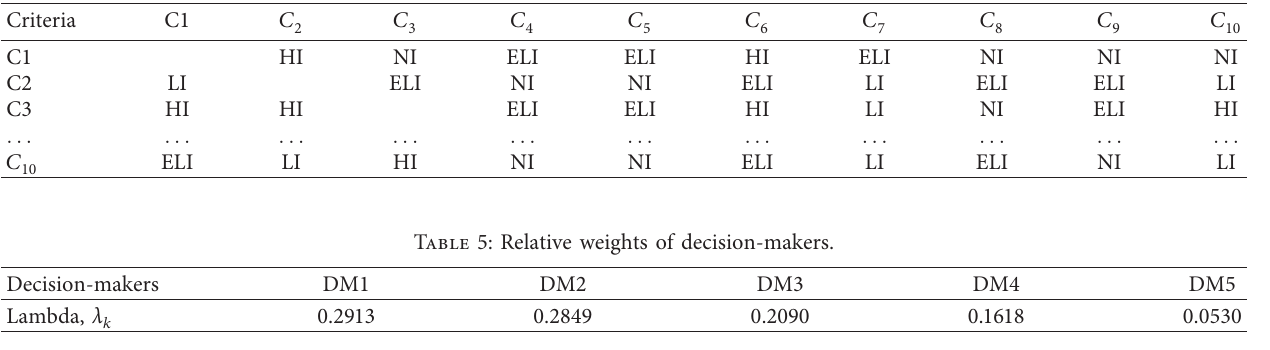
Table 4: Judgments of criteria (DM1).